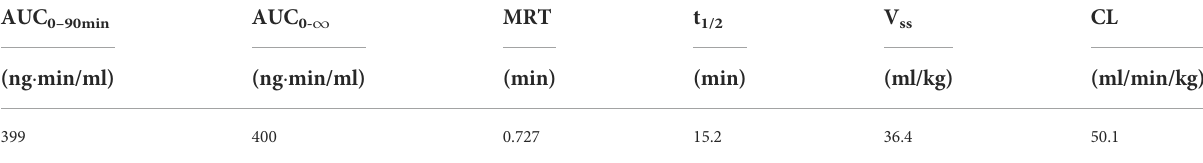
TABLE 1 Pharmacokinetic parameters of BPC157 in rats following a single intravenous administration (mean ± SD, n = 6). AUC 0 – 90min